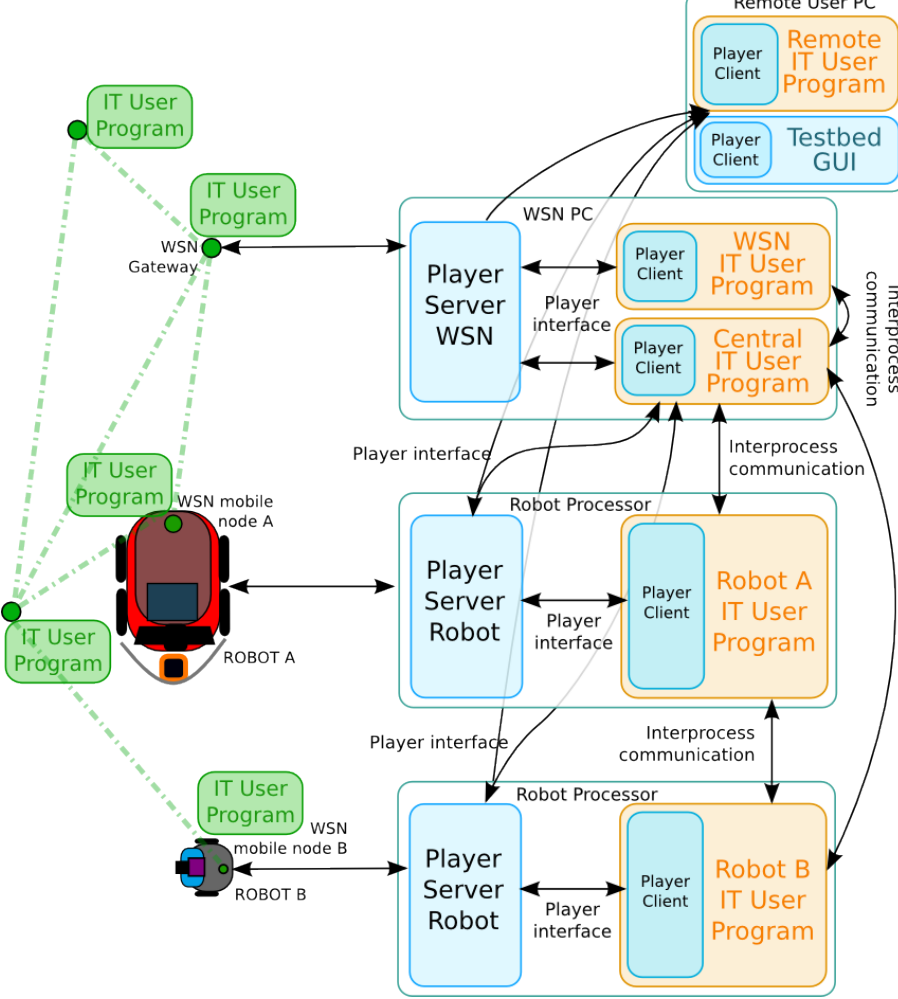
Figure 5. General scheme of the testbed software architecture. Player (blue squares) runs in each robot processor and in the WSN PC, connecting all elements (WSN nodes, robots and sensors). The user is allowed to program each WSN node (green square), robot, WSN PC and central controller (orange